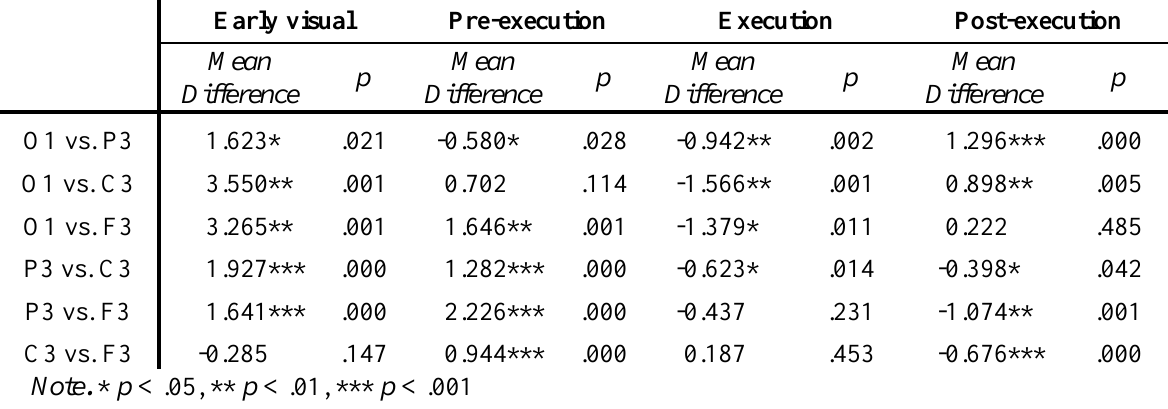
Figure 4. Averaged ERP curves of 16 subjects recorded from the left hemisphere